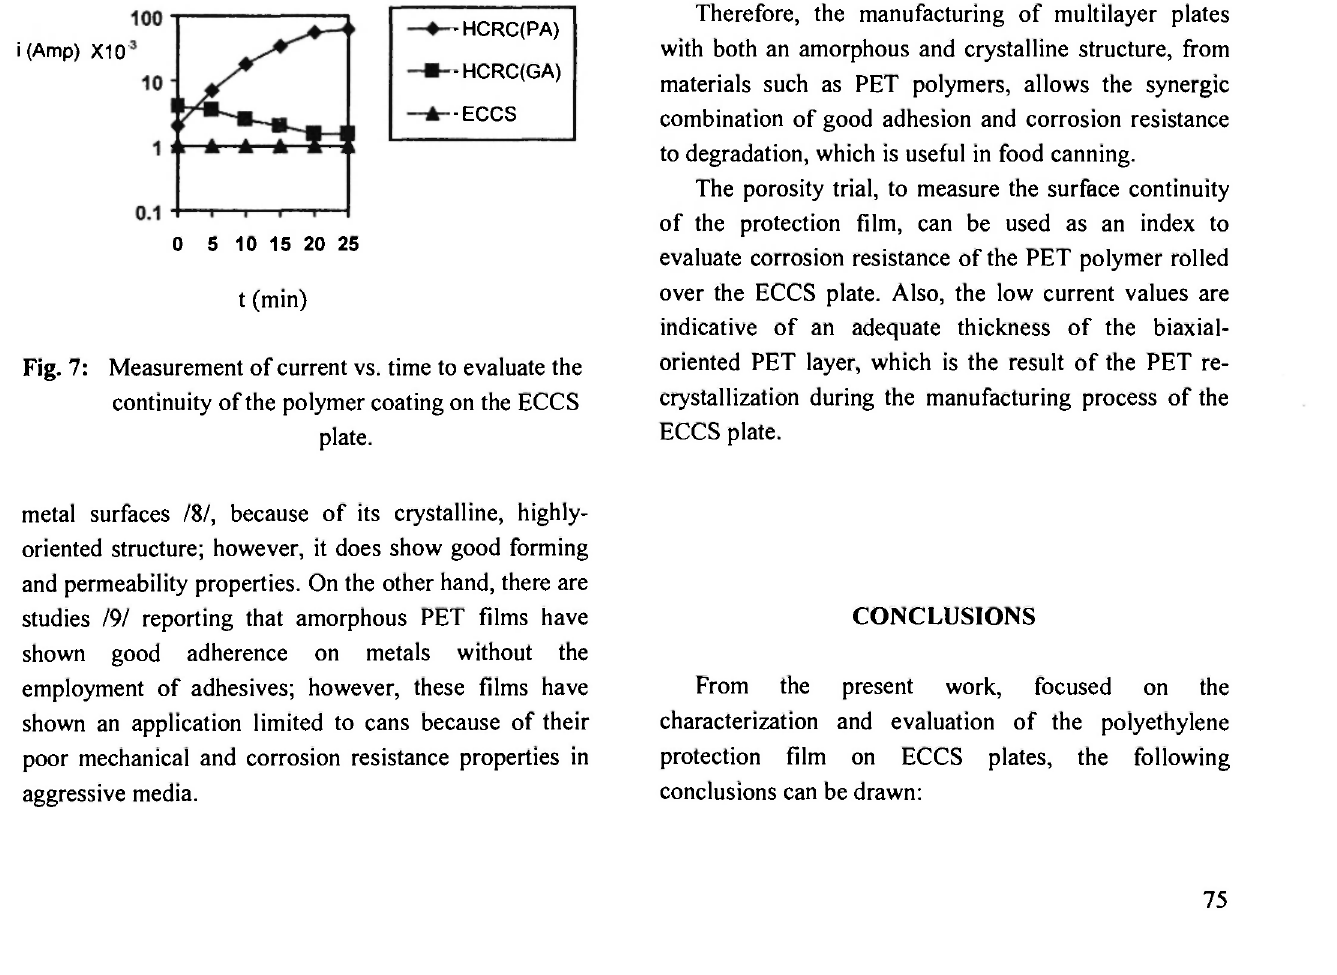
Fig. 6: Spectra of the internal and external coatings on the ECCS plate obtained by ATR and FT-Raman spectroscopy. The internal and external layers correspond to the pure PET and LDPE coatings, respectively.